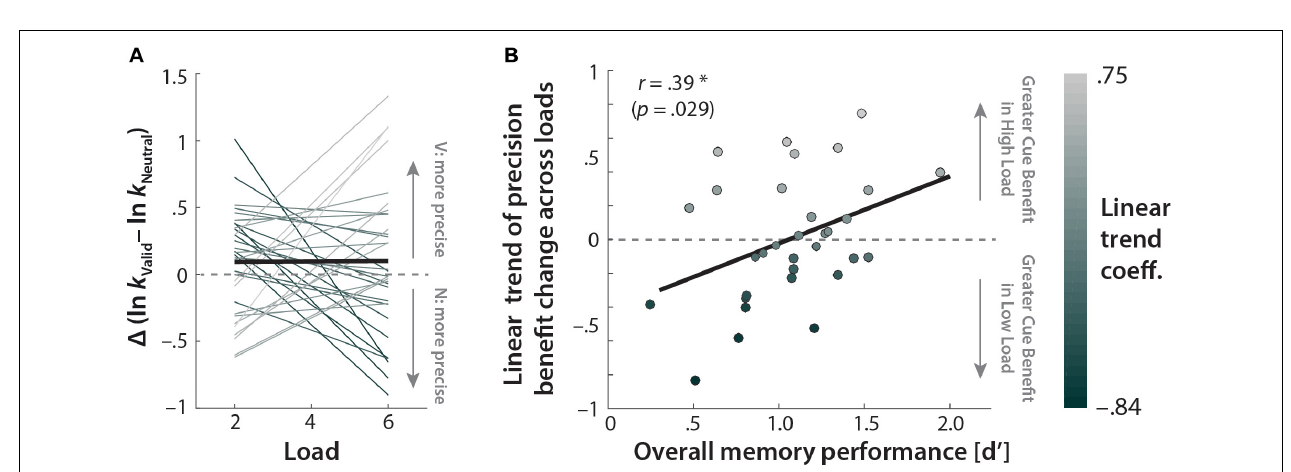
FIGURE 6 | Memory load affects individual differences in the amount of cue-related precision benefit. (A) Thin colored lines indicate individual participants’ linear trends for the effect of memory load (2, 4, 6 syllables in memory) on the cue-related precision benefit (ln k Valid –ln k Neutral ). Line colors correspond to individuals’ linear-trend coefficients. The bold black line indicates the average linear trend. (B) Correlation between individual’s overall memory performance ( d (cid:48) ) and the linear change in the cue benefits with increased memory load. The colors of the dots correspond to individuals’ ( N = 32) linear-trend coefficients as in (A)